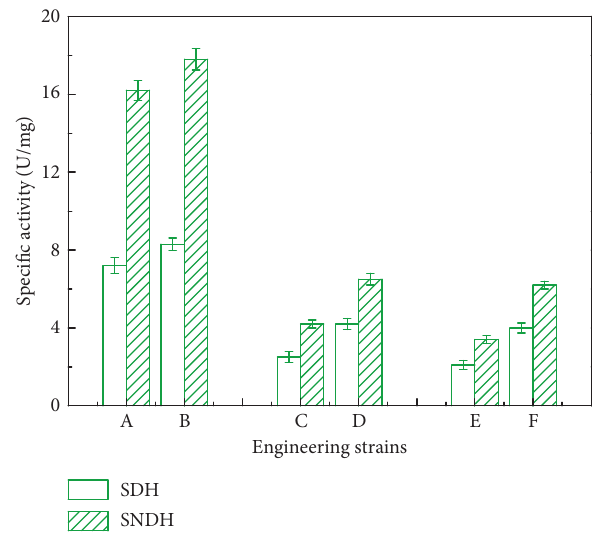
Figure 6: The specific activities of SDH and SNDH in the CutA-based engineered strainandthe controlstrainatdifferent temperatures.A, C, and E are SDH and SNDH specific activities of G. oxydans /pGUC- tufB - sdh -GGGGS- sndh at 30 ° C, 35 ° C, and 37 ° C, respectively. B, D, and F are SDH and SNDH specific activities of G. oxydans /pGUC- tufB - SH3 - sdh -GGGGS- sndh - tufB - SH3 lig -(GGGGS) 2 - cutA at 30 ° C, 35 ° C, and 37 ° C, respectively. Error bars represent the standard deviation of three biological replicates.